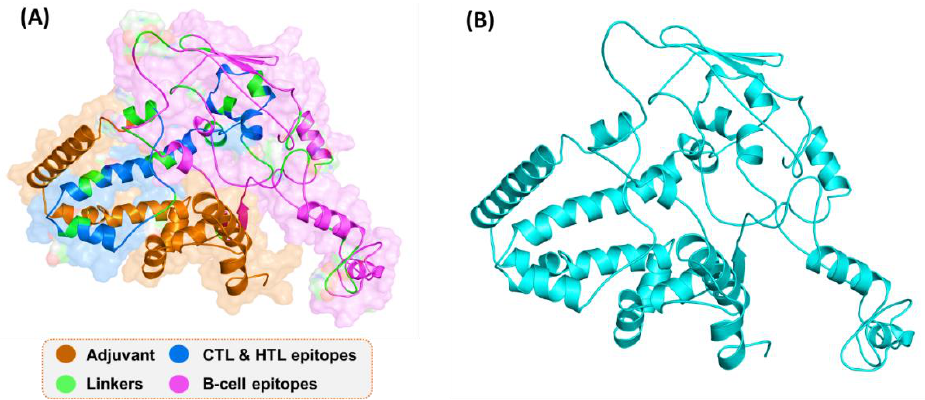
Figure 4. 3D structure of the final vaccine construct. ( A ) The distribution of different peptides and linkers on the protein surface; ( B ) The 3D structure of the final vaccine construct.